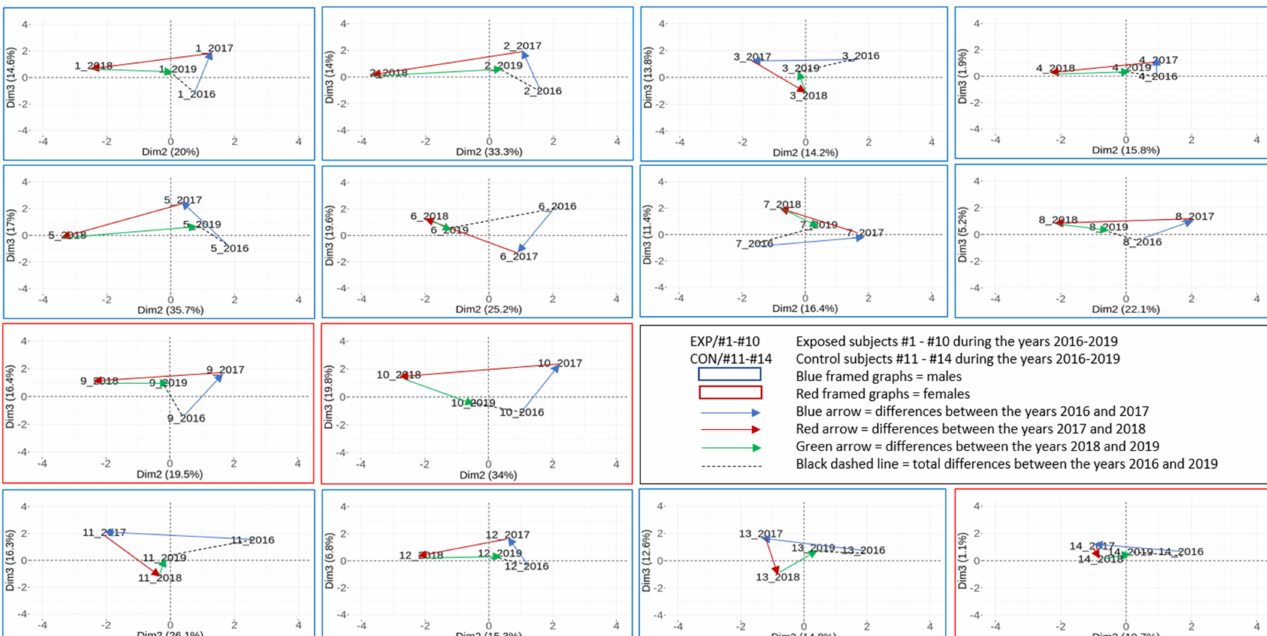
Figure 5. Individual DNA methylation pattern trajectories of the exposed and control subjects analyzed by PCA in four consecutive years: results of the selected 14 CpG data set analyzed by array chips. Three-year differences between the years 2016 and 2019 (dashed line) were used for the calculations of the range of changes in the exposed and control subjects (details in Section